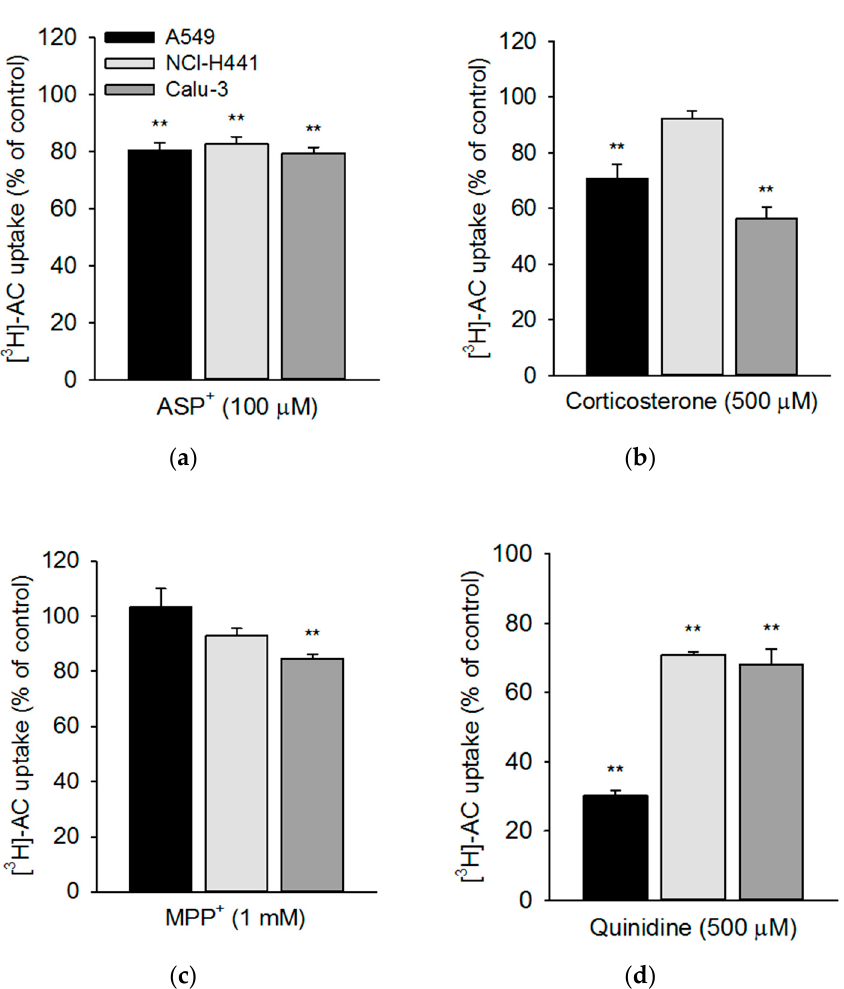
Figure 4. [ 3 H]-AC uptake was studied in the presence and absence of OCT/N modulators in human respiratory epithelial cells. [ 3 H]-AC uptake was studied in A549 (black columns), NCl-H441 (light grey columns), and Calu-3 (dark grey columns) cells after 20 min in the presence of ( a ) ASP + (100 µM), ( b ) corticosterone (500 µM), ( c ) MPP + (1 mM), and ( d ) quinidine (500 µM) at 37 °C and at pH 7.4. Results were obtained by calculating the difference between uptake at 37 °C and 4 °C. Data represent mean ± SEM ( n = 6–9). ** p < 0.01 indicates a significant difference from data obtained in the absence of substances (control).